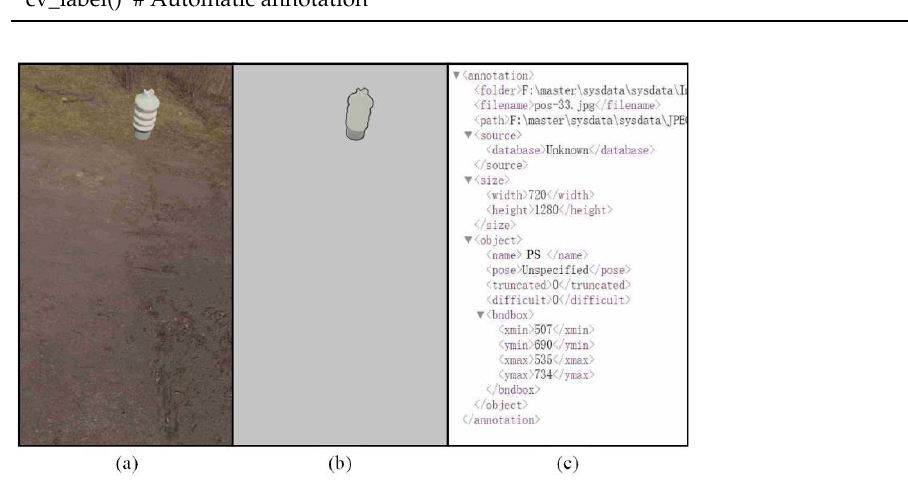
Figure 8. Example of a prior synthetic dataset. ( a ) Normal image; ( b ) backgrounded-free image; ( c ) annotation.